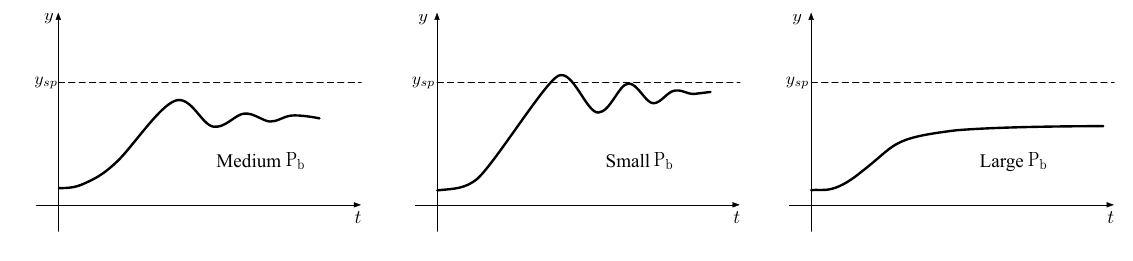
Figure 3. System response for different P b